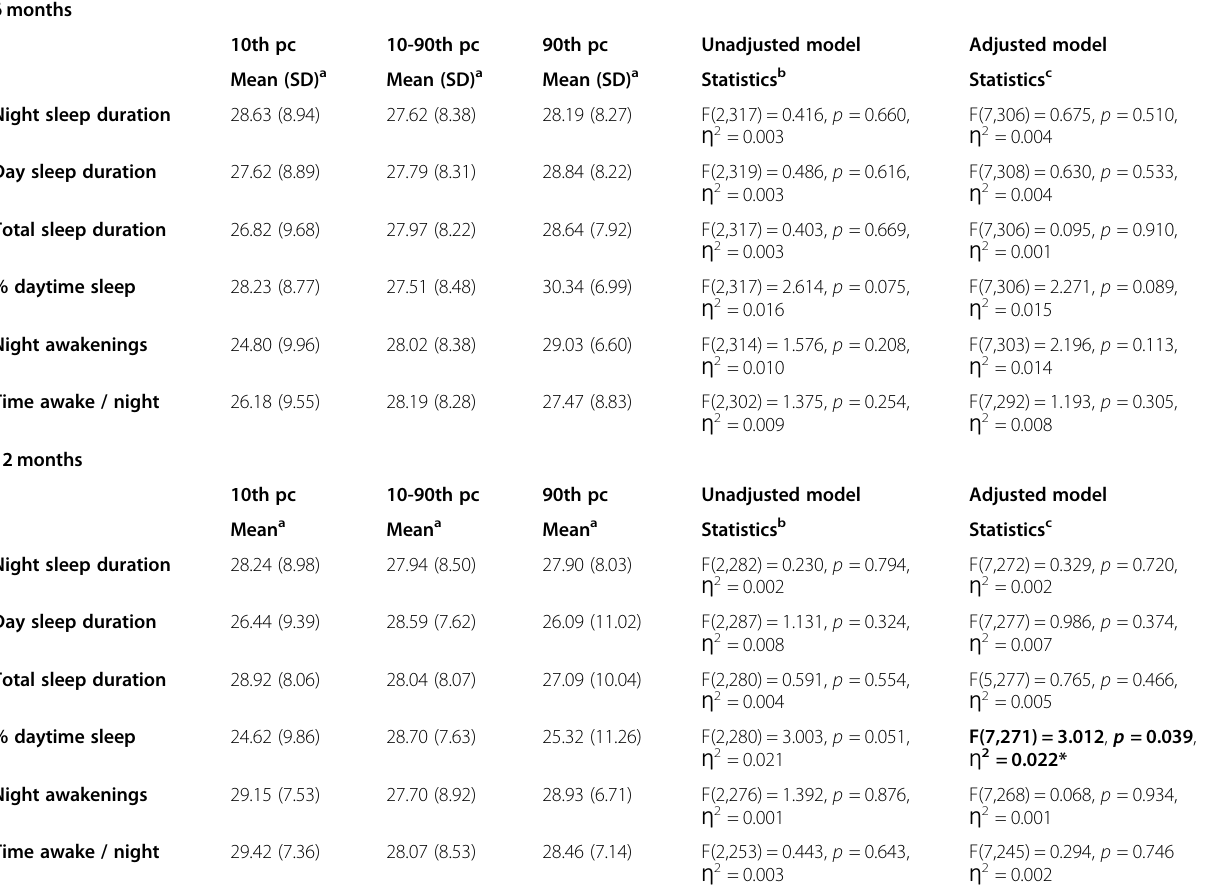
Table 4 The differences between sleep category at 6 months and 12 months in predicting child inhibitory control at 30